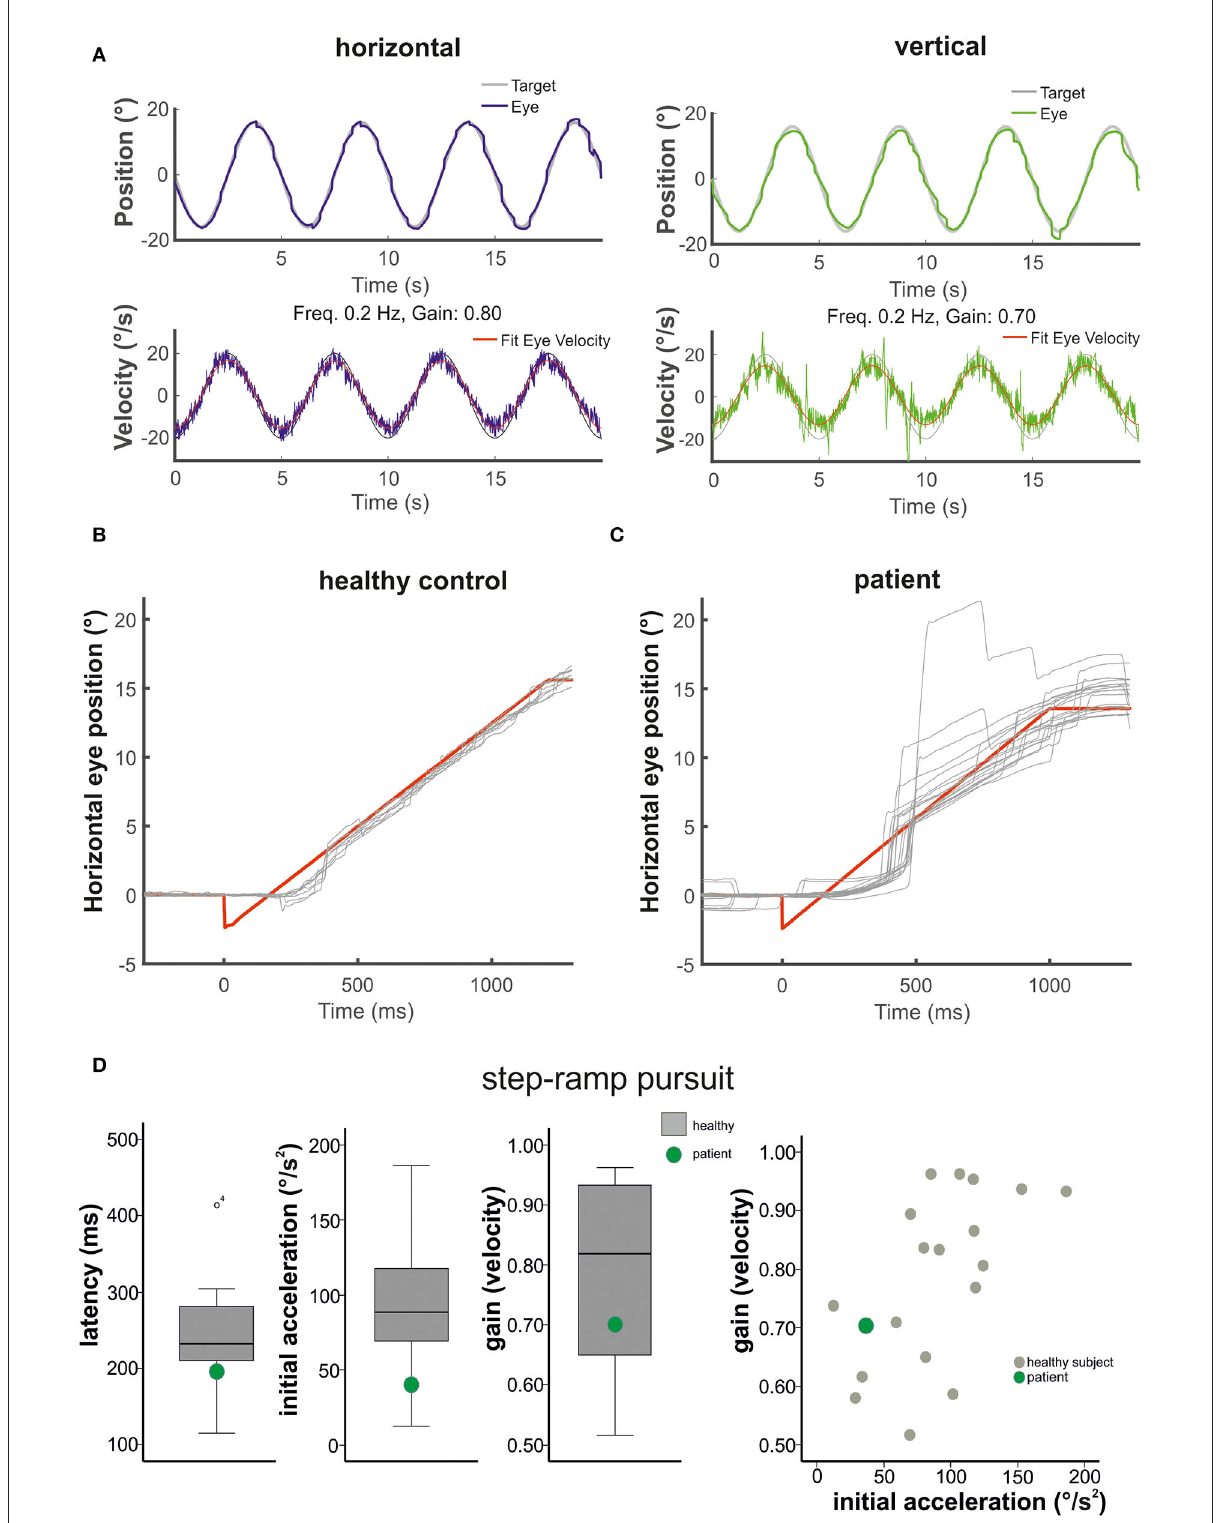
FIGURE2 The figure shows in (A) the horizontal (left) and vertical (right) sinusoidal smooth pursuit of the patient. Upper traces indicate horizontal (blue) and vertical (green) eye position (target in gray), and lower traces indicate horizontal (blue) and vertical (green) eye velocity ( ◦ /s). The responses to the step-ramp stimuli (target = red) are shown in (B) for a healthy control subject and the patient (C) . Note the low initial acceleration in the